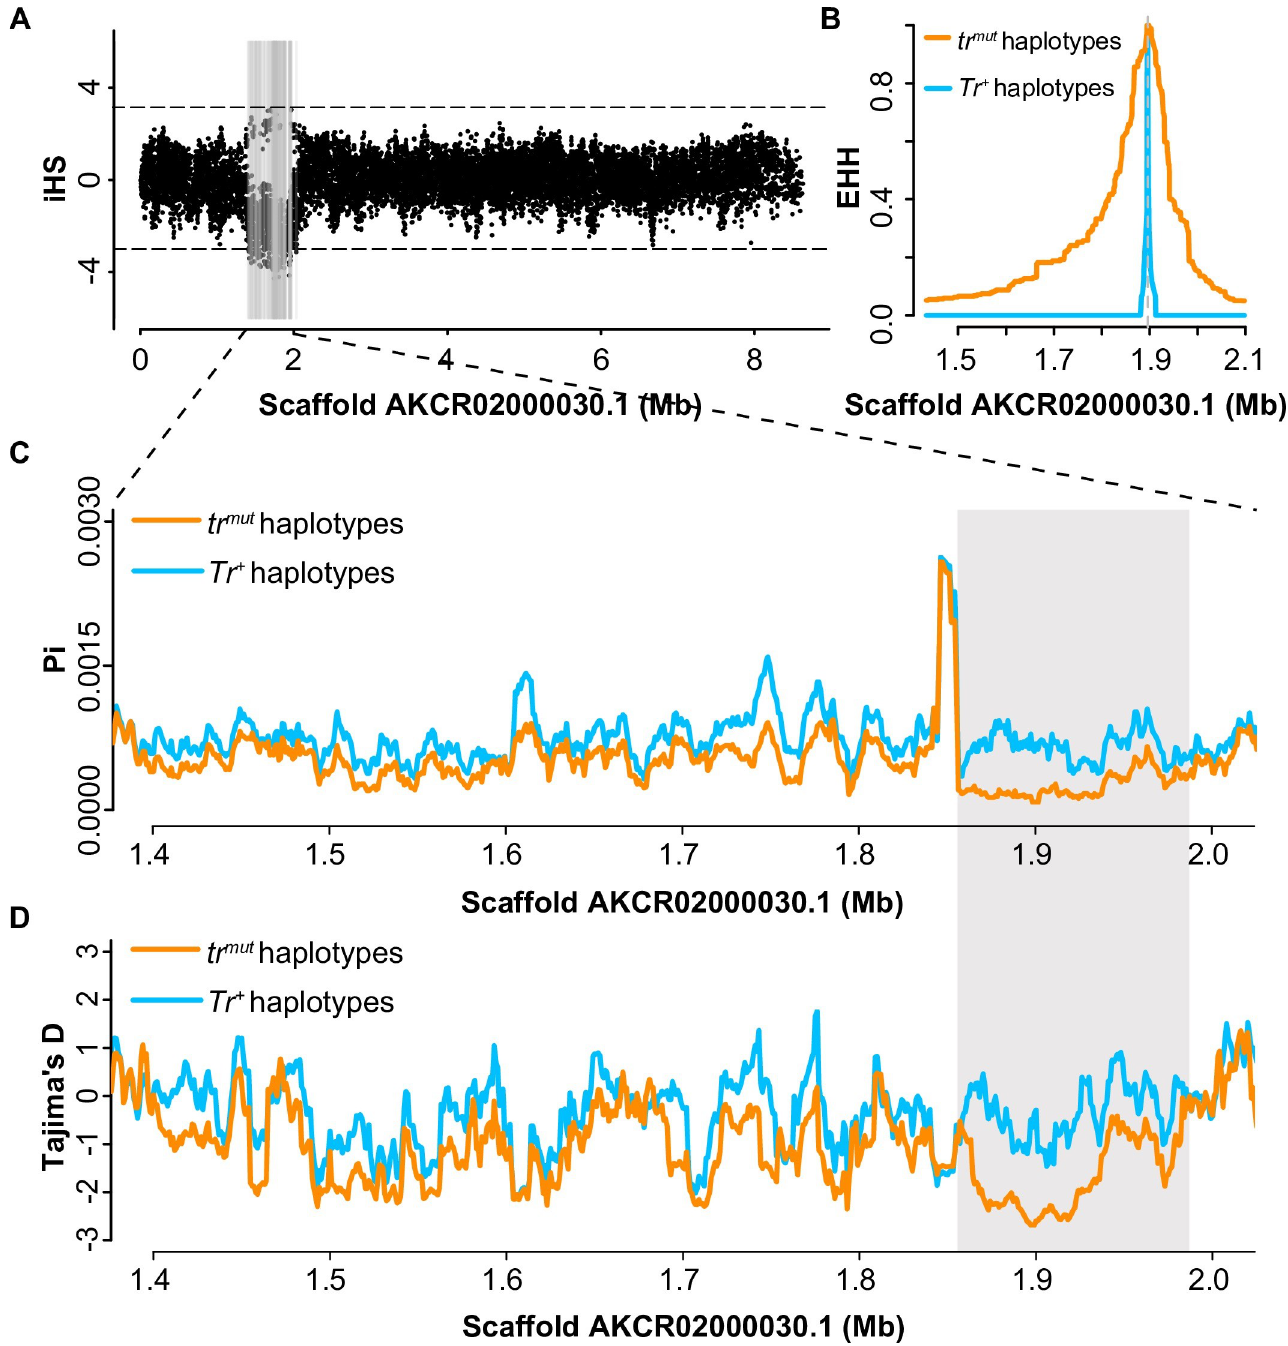
Fig 6. Selection of the pearl iris variant tr mut in domestic pigeons. (A) The distribution of integrated haplotype score (iHS) values on scaffold AKCR02000030.1. The gray lines indicate the significance of the absolute iHS scores of 3 or greater. (B) Extended haplotype homozygosity (EHH) decay across the Tr locus region. Nucleotide diversity ( π , Pi) (C) and Tajima’s D (D) were calculated in 10 kb windows with a 1 kb step size for tr mut and Tr +